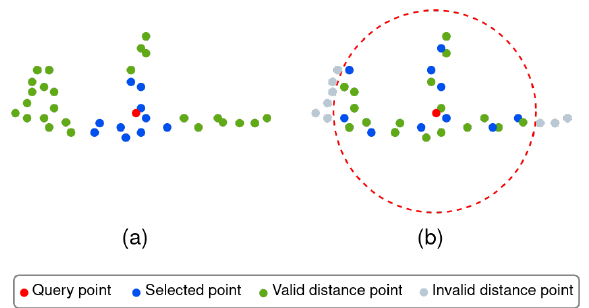
Figure 5. Schema of a K-NN selection (a) and a fixed distance neighborhood selection